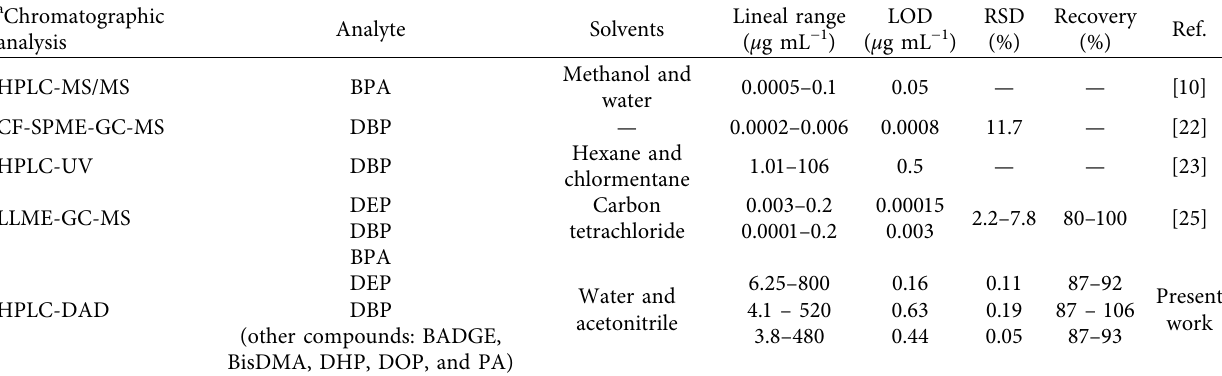
Table 2: Chromatographic methods for phthalate and bisphenol quantification and their comparison with the proposed method. a Chromatographic